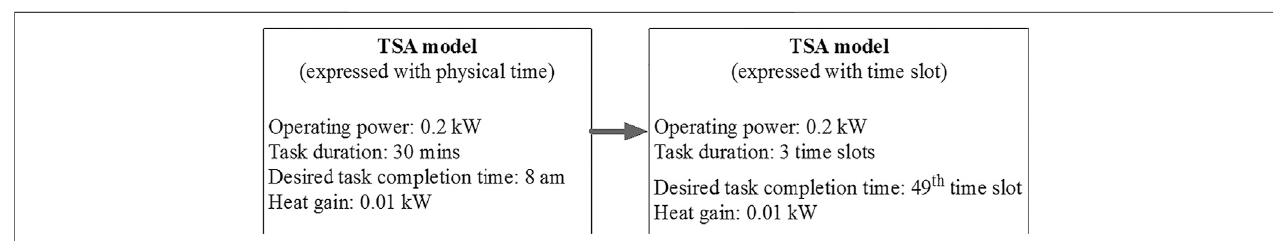
FIGURE 2 | Illustration of a TSA model (considering that the scheduling period starts from 7:30 am and the duration of each time slot is 10 min).